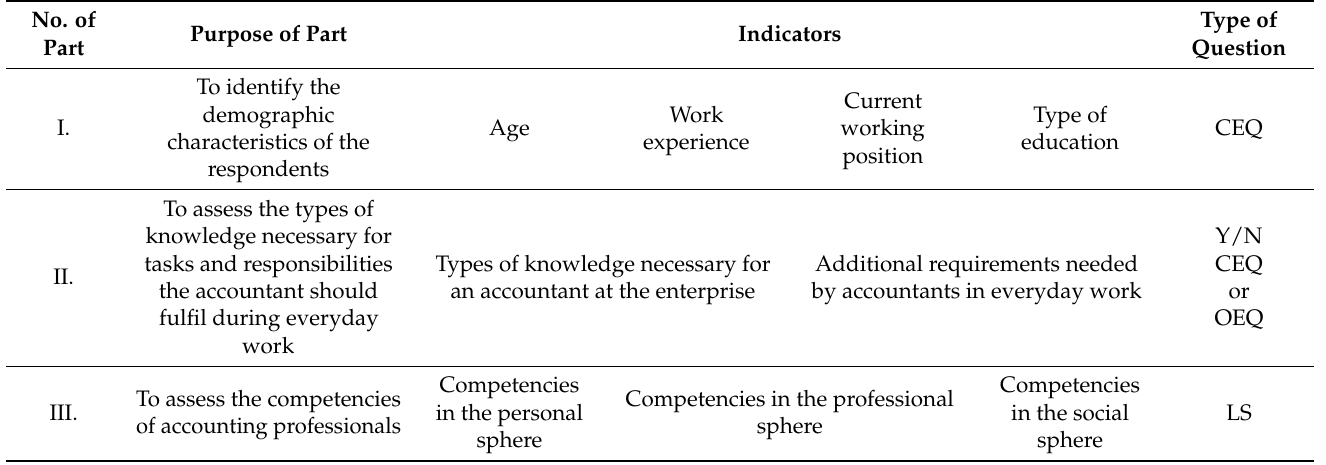
Table 1. Structure of the Questionnaire.